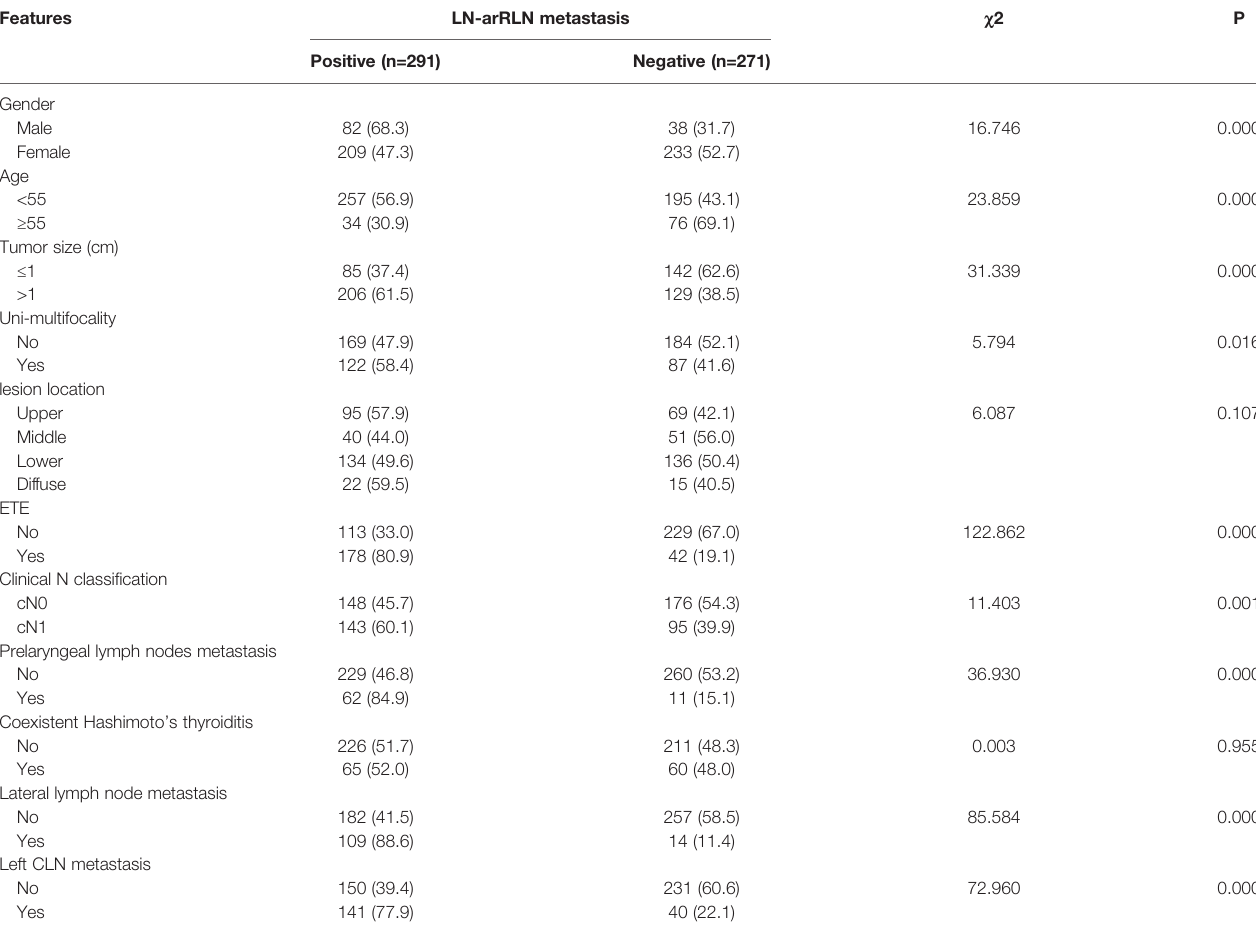
TABLE 3 | Univariate analysis of predictor for lymph nodes anterior to the right recurrent laryngeal nerve (LN-arRLN).